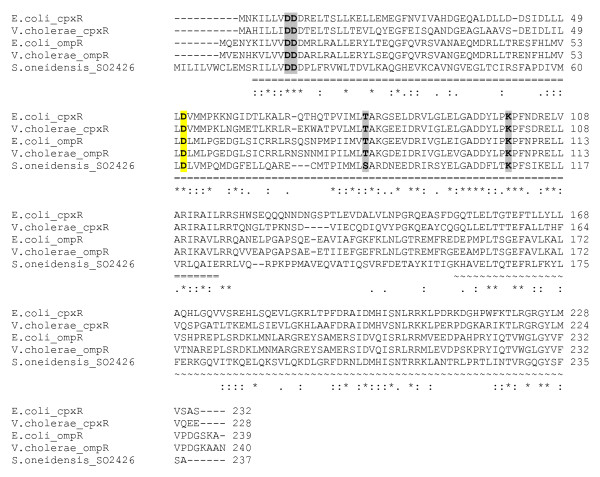
Sequence alignment of S. oneidensis SO2426 with other two-component response regulators. ClustalW [20] was used to perform a multiple sequence alignment consisting of S. oneidensis SO2426 (GenBank ID 24348419), CpxR from E. coli (GenBank ID 16131752) and Vibrio cholerae (GenBank ID 147675245), and OmpR from E. coli (GenBank ID 16131282) and V. cholerae (GenBank ID 147673571). The region underlined with "=" is the aligned regulator receiver domain with predicted domain (SO2426: positions 13–124), and the region denoted with "~" is the aligned C-terminal domain containing the wHTH DNA-binding motif (SO2426: positions 158–235). Boldface letters highlighted in grey indicate conserved signature residues of receiver domains [19]. Residue D62 is predicted as 4-aspartylphosphate, the putative phosphorylation site (highlighted in yellow). The star, colon, and dot notations rank the sequence conservation from high to low.